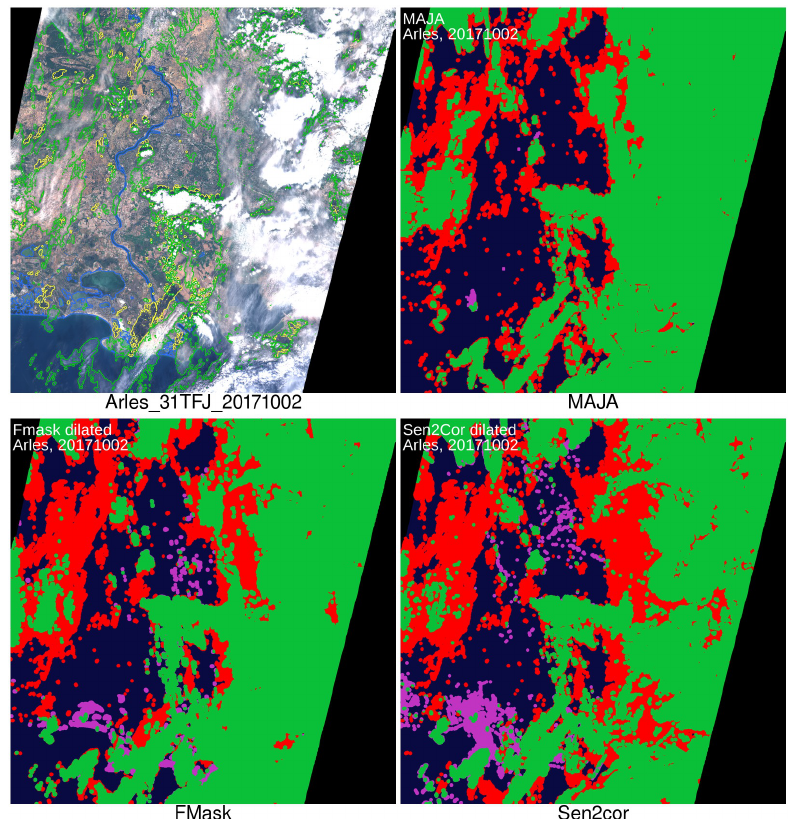
Figure 7. The top left image shows the image from Arles on 02 October 2017, with the overlayed contours from ALCD, as in Figure 3. The three other images show the comparison of each processor to ALCD reference masks (top-right, MAJA, bottom-left, FMask, and bottom-right, Sen2Cor). Green color corresponds to true positive, red color to false negative, deep blue to true negative, and purple to false positive.